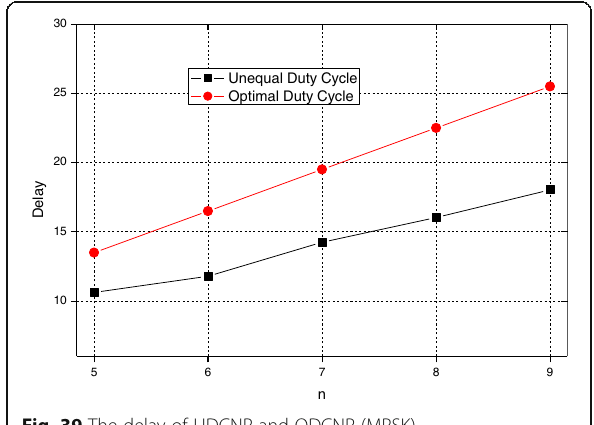
Fig. 39 The delay of UDCNP and ODCNP (MPSK)